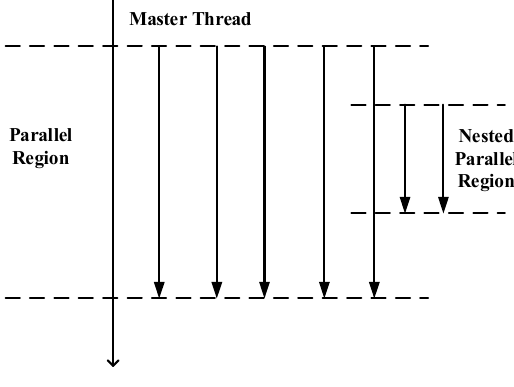
Figure 1. Fork-Join model in OpenMP.